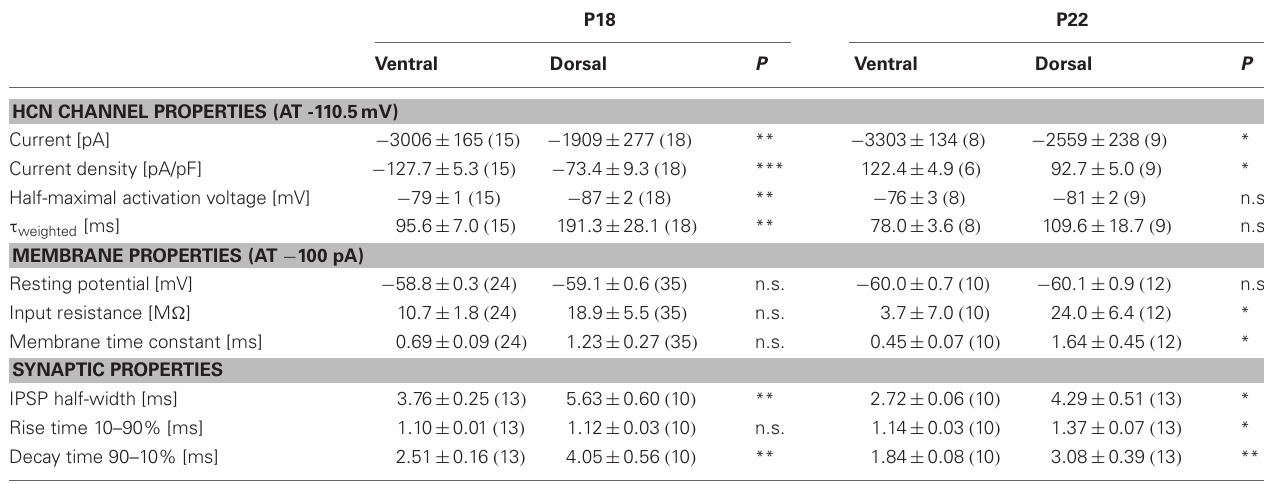
Table 1 | Summary of HCN channel properties, membrane properties and synaptic properties of dorsal and ventral neurons for P18 and P22. P18 P22 Ventral Dorsal P Ventral